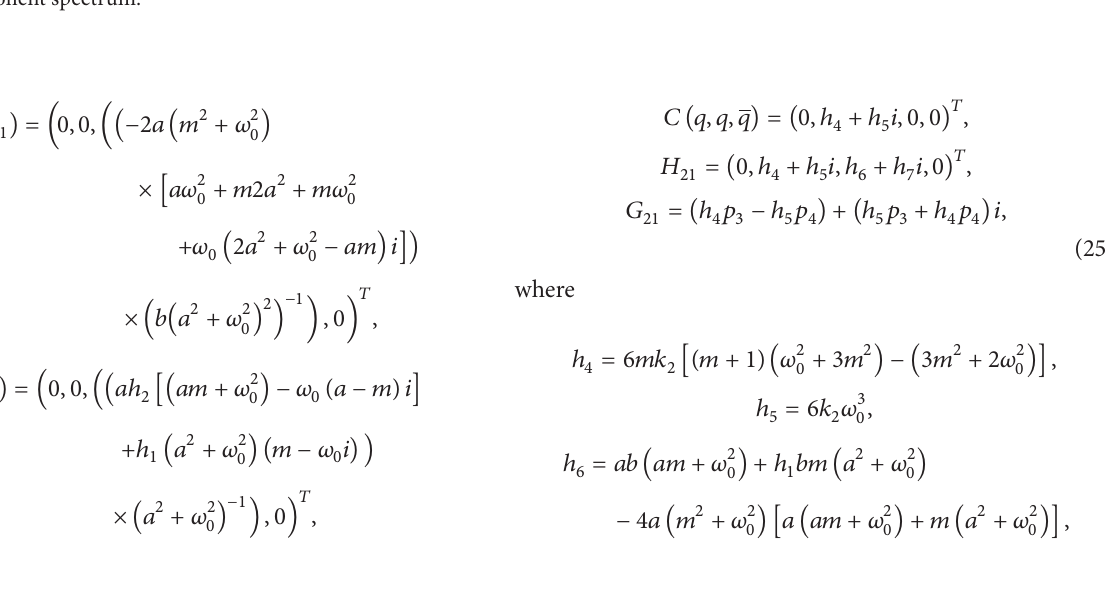
Figure 10: Nonlinear dynamics of system (1) for specific values 𝑎 = 1 , 𝑏 = 2 versus the control parameter 𝑐 . (a) Bifurcation diagram of 𝑦 . (b) Lyapunov exponent